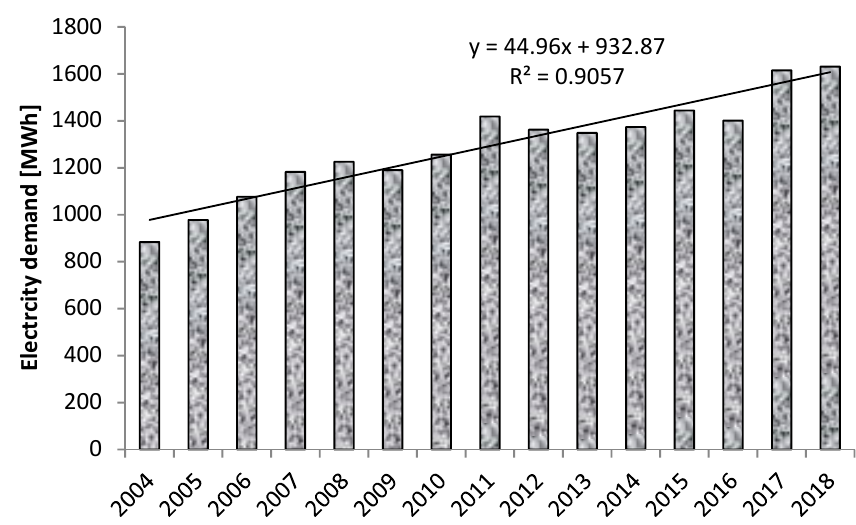
Figure 2. Annual electricity production (2004–2018) [11].